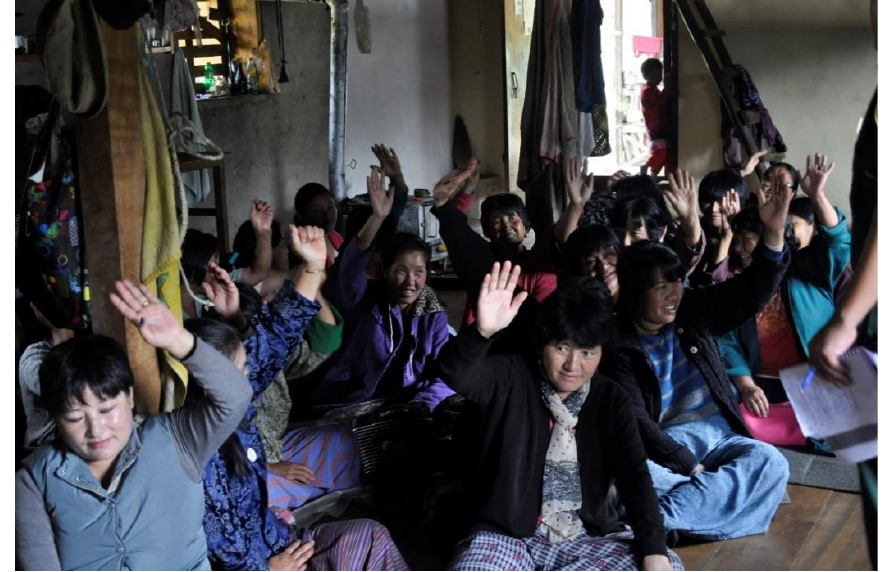
Figure 3. Female participants in one of the focus group discussion at Trashigang dzongkhag .